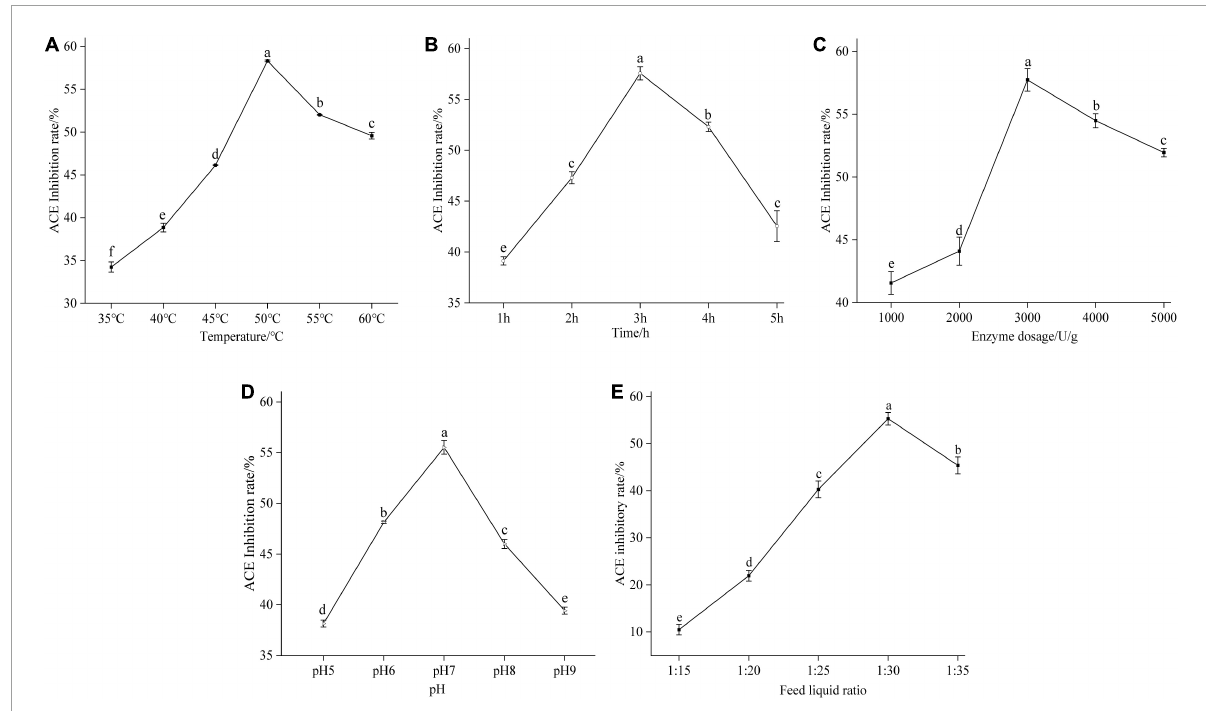
FIGURE2 Effect of temperature (A) , time (B) , enzyme dosage (C) , pH (D) , and feed liquid ratio (E) on the degree of the ACE inhibitory rate of mulberry leaf protein hydrolysate. Means denoted by a different letter indicate significant differences between treatments ( P < 0.05).